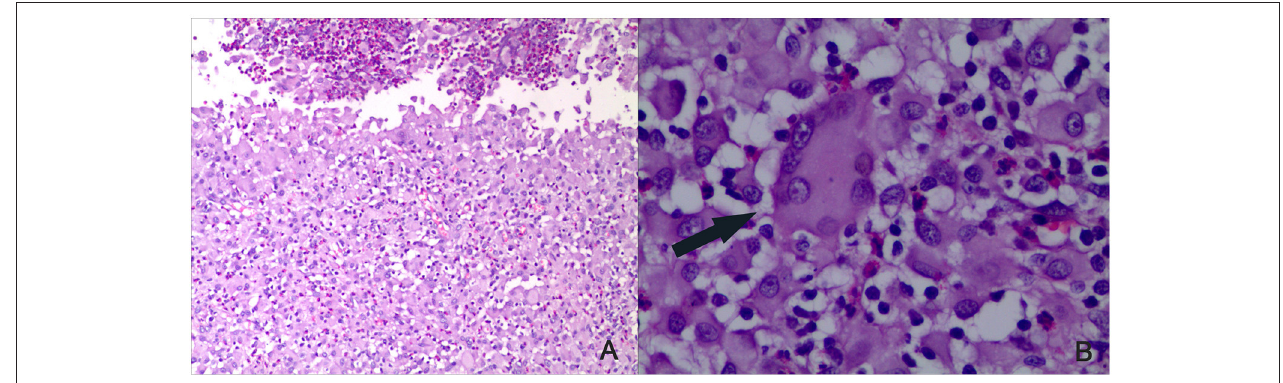
FIGURE 1 | Histopathology of the rabbit skin lesions (HE staining). BCG was used to induce rabbit skin lesion. As all groups showed same pathologic reaction, a representative skin lesions is shown after BCG challenge. After the lesions healed, tissue sections were made. (A) Infiltration of epithelioid cells, macrophages, and lymphocytes could be seen along with unabsorbed liquefied material and necrosis ( × 100). (B) Langhans giant cells as indicated by the arrow could be seen ( × 400).